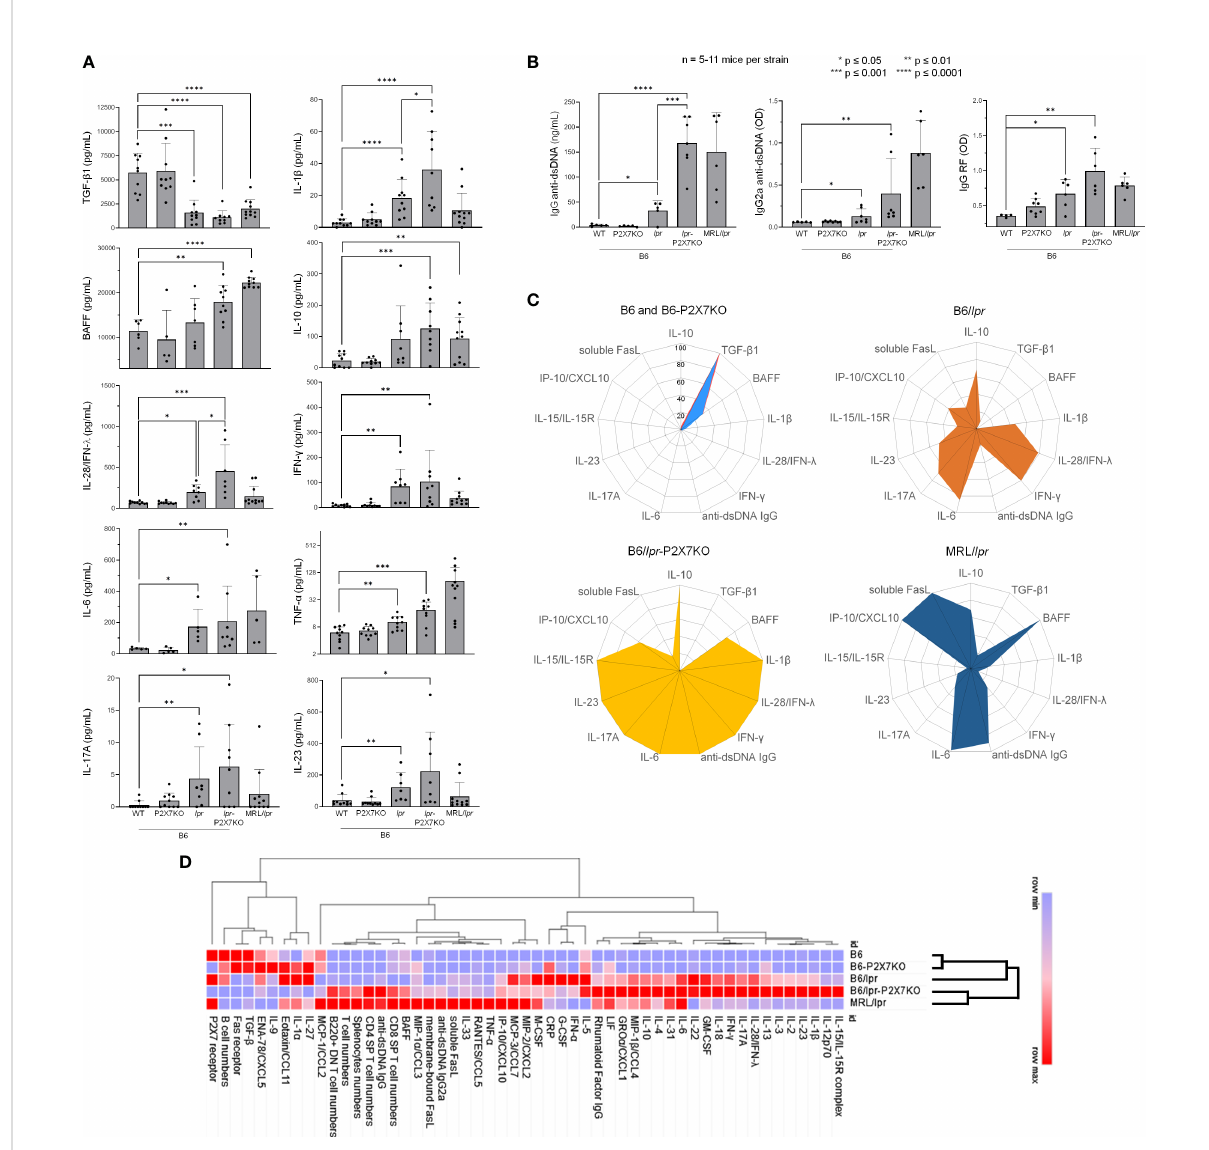
FIGURE 6 Cytokine and autoantibody levels in sera from B6 /lpr - p2x7 KO mice and parental strains as well as hierarchical clustering of autoimmune features. Bar graphs show serum levels of (A) the cytokines TGF- b 1, IL-10, BAFF, IFN- g , IL-28/IFN- l , IL-1 b , IL-6, TNF- a , IL-17A, and IL-23, as well as (B) total IgG and IgG2a anti-dsDNA and IgG RF autoantibodies in 6- to 7-month-old female and male wildtype B6, single-mutant B6- p2x7 KO, and B6/ lpr mice and double-mutant B6/ lpr - p2x7 KO mice, as well as 4-month-old female MRL/ lpr mice. Data are expressed as mean (SD) of 5-11 mice per strain, and each dot in the bar graphs represents an individual mouse. Error bars in graphs show SD. Asterisks above horizontal lines indicate statistically signi fi cant differences assessed with unpaired two-tailed t -test. *p ≤ 0.05, **p ≤ 0.01, ***p ≤ 0.001 ****p ≤ 0.0001. (C) Radar plot pro fi les of the cytokine and anti-dsDNA autoantibody levels in B6 and B6- p2x7 KO (upper panel, left), B6/ lpr (upper panel, right), B6/ lpr - p2x7 KO (lower panel, left), and MRL/ lpr (lower panel, right) mice. Using min-max normalization, we rescaled data values of every feature between 0 and 1 via the formula x ’ = (x – min(x))/(max(x) – min(x)) where min(x) and max(x) are the minimum and the maximum values of the feature, respectively. (D) Heat map and hierarchical clustering of cellular and serological features from B6, B6- p2x7 KO, B6/ lpr , B6/ lpr - p2x7 KO, and MRL/ lpr mice. For each feature, measured data were normalized (min-max normalization) and loaded in the data-processing software Morpheus (Broad Institute). The color gradient represented the lowest (blue) and highest (red) value found among the fi ve mice strains. Hierarchical clustering was applied using one minus Pearson correlation to assess whether clinical and biological parameters from B6/ lpr - p2x7 KO cluster with those of B6/ lpr and/or MRL/ lpr